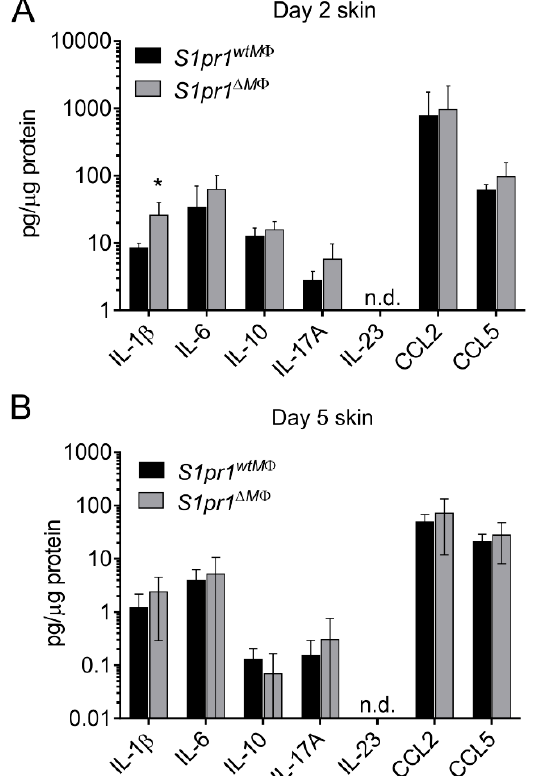
Figure 6. Chemokine and cytokine released in psoriatic skin of S1pr1 ∆ M Φ mice. ( A , B ) S1pr1 wtM Φ (black bar) and S1pr1 ∆ M Φ (grey bar) mice were treated daily with 62.5 mg IMQ on the back skin for up to 5 days. ( A ) CBA analysis of day 2 IMQ-treated back skin, normalized to protein content of the skin lysate. Data are means ± SD, n = 4 individual animals ( B ) CBA analysis of day 5 IMQ-treated back skin, normalized to protein content of the skin lysate. Data are means ± SD, n = 7 ( S1pr1 wtM Φ ) and n = 9 ( S1pr1 ∆ M Φ ) individual animals. * p < 0.05; p values were calculated using two-tailed multiple t -test with Holm–Š í d á k correction (C-D). n.d., not